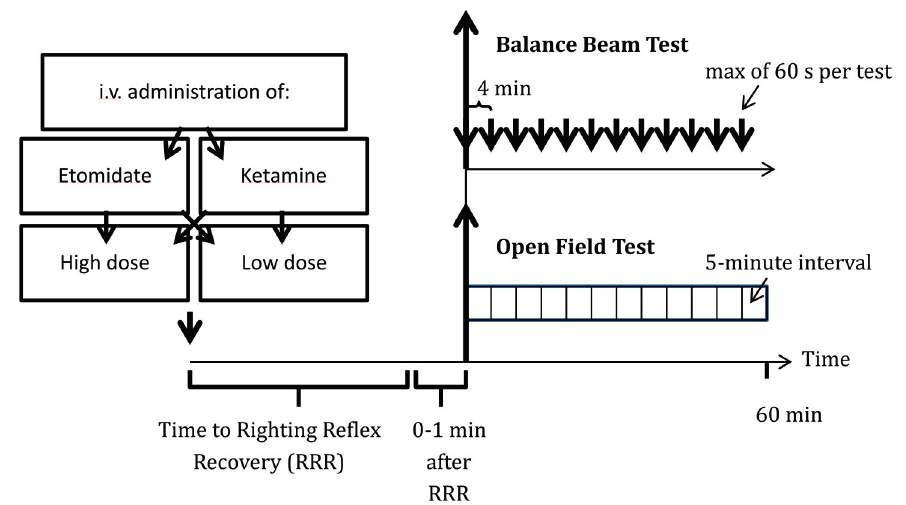
Figure 1. Protocol used to evaluate etomidate’s and ketamine’s residual effects on functional mobility, motor behavior and anxiety-related behavior. Rats received i.v. ketamine or etomidate in high or low doses (20 or 40 mg/kg ketamine vs. 2 or 4 mg/kg etomidate) in a cross-over fashion. Following drug administration, the time to recovery of righting reflex was recorded, followed by balance beam and open field tests at 4- and 5-minute intervals,